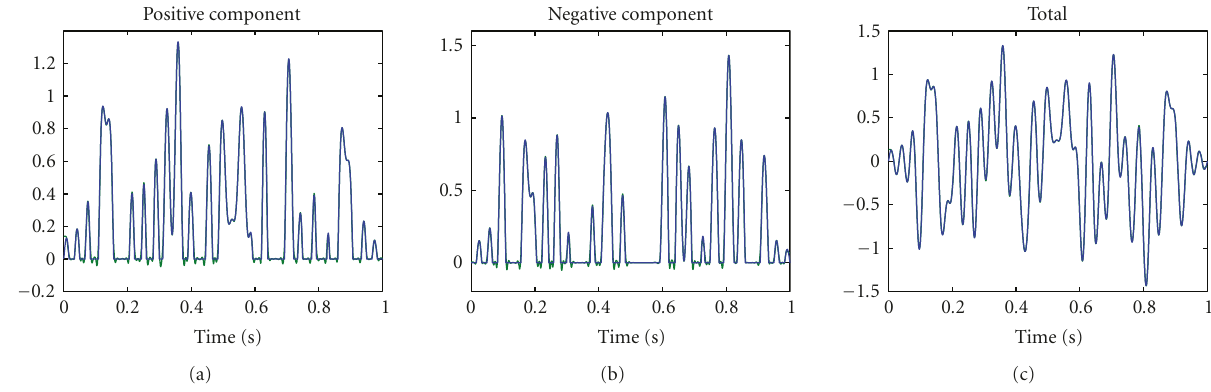
Figure 4: Encoding the stimulus velocity with a pair of rectifier LIF Neurons. (a) Positive signal component. (b) Negative signal component. (c) Reconstructed